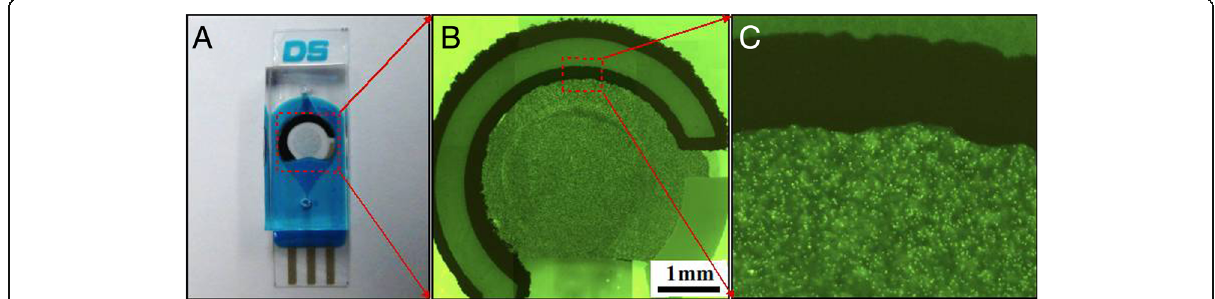
Fig. 2 a Screen-printed photoelectrode used to take fluorescence images. b Fluorescence image of CASPE-MFD. We use a photoelectrode as a model fluorescence image to demonstrate that the working area is full with dyes and has no bubbles in the CASPE-MFD. c Partial enlarged drawing of the fluorescence